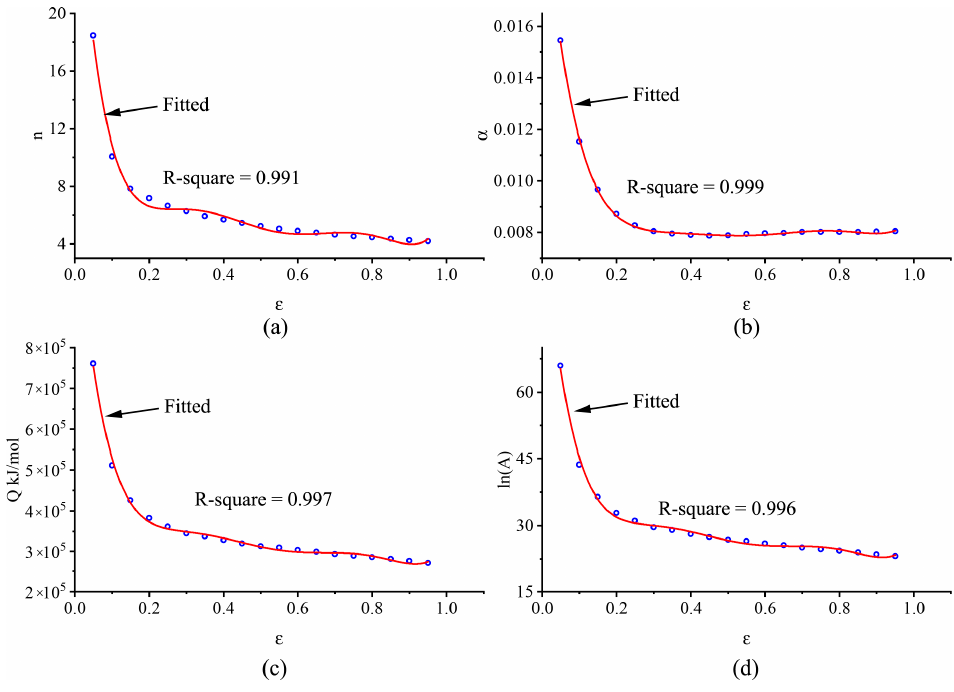
Figure 8. The polynomial fitting process of model parameters. ( a ) n , ( b ) β , ( c ) Q , ( d ) ln A .